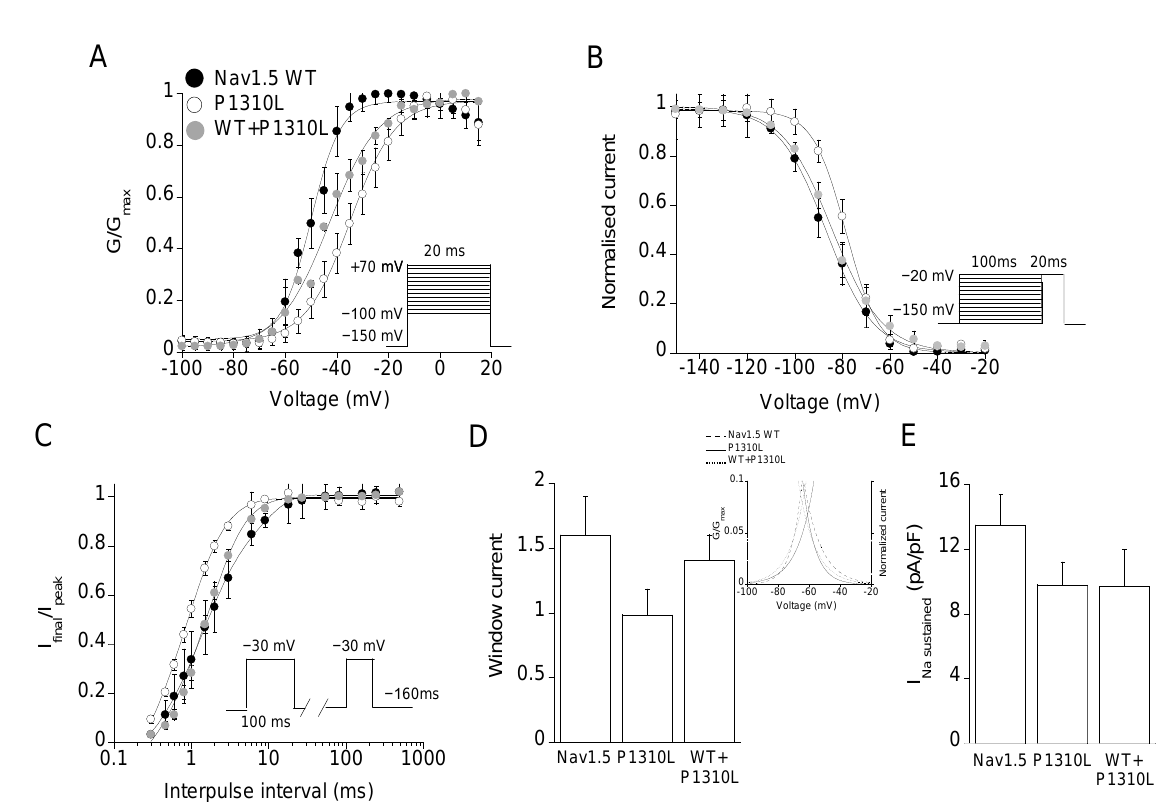
Figure 4. Biophysical properties of Nav1.5 WT, P1310L, and WT+P1310L channels expressed in HEK 293 cells. ( A ) Voltage- dependence of activation. ( B ) Voltage-dependence of fast inactivation. ( C ) Recovery from fast inactivation. Voltage protocols are indicated in the insets and detailed in the Supplementary Materials and Methods. ( D ) Bar graph showing window current measure for the indicated channels. The inset shows the triangular area under the overlapping point of the activation and inactivation curves of the respective channels. ( E ) Bar graph showing the amplitude of the sustained current measured at the end of a 100 ms pulse at − 30 mV for the indicated channels. Data are mean ± SE; n = 6–20